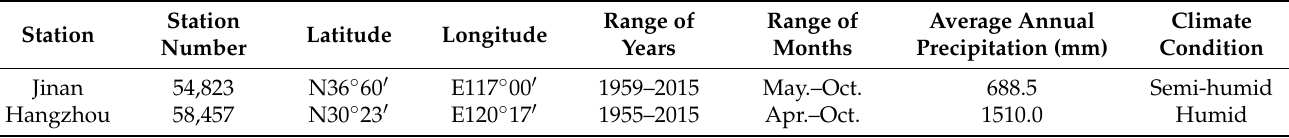
Table 1. Geographic and climatic information of the rain gauge stations for two case study areas.